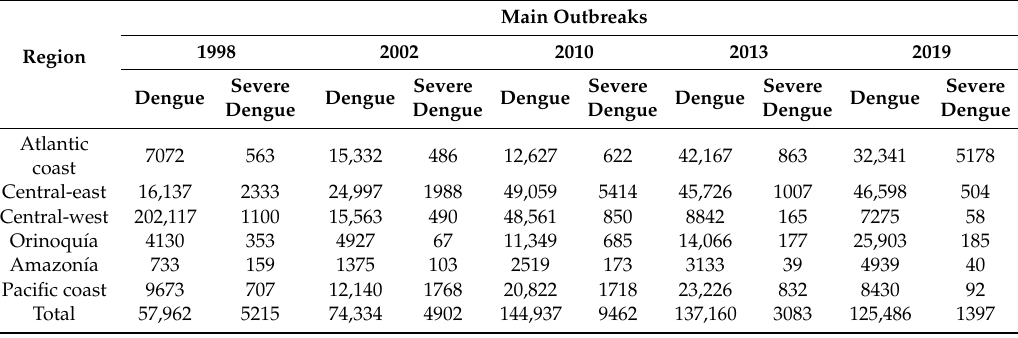
Figure 7. Reported cases of Dengue disease by region through the five most important outbreaks: Division of the Colombian territory by regions ( A ); Heat map of Colombian regions according to Dengue reported cases through the most important outbreaks in 1998 ( B ), 2002 ( C ), 2010 ( D ), 2013 ( E ), and 2019 ( F ) [13 − 16]. Table 1. Dengue and Severe Dengue Cases by Regions in the Five Primary